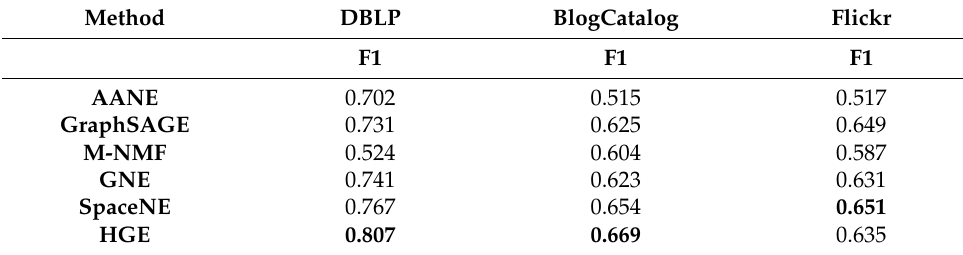
Table 3. Node classification